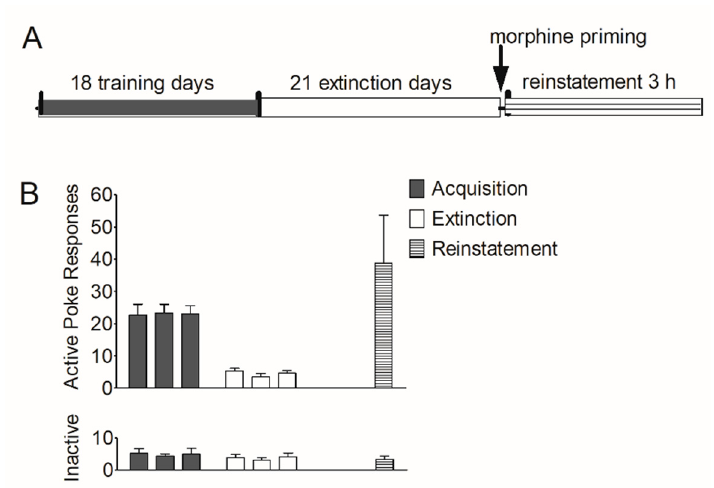
Figure 1. Acquisition, extinction, and reinstatement of morphine-seeking behavior in rats. ( A ) Time- line of acquisition, extinction, and morphine priming-induced reinstatement in rats. ( B ) The number of active pokes and inactive pokes in the last 3 training sessions, the last 3 extinction sessions, and the reinstatement session ( n = 8). Data are expressed as mean ± SEM.